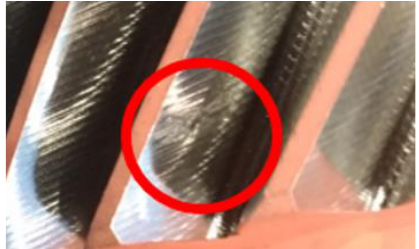
Figure 2. Double helical gear after power skiving machining.